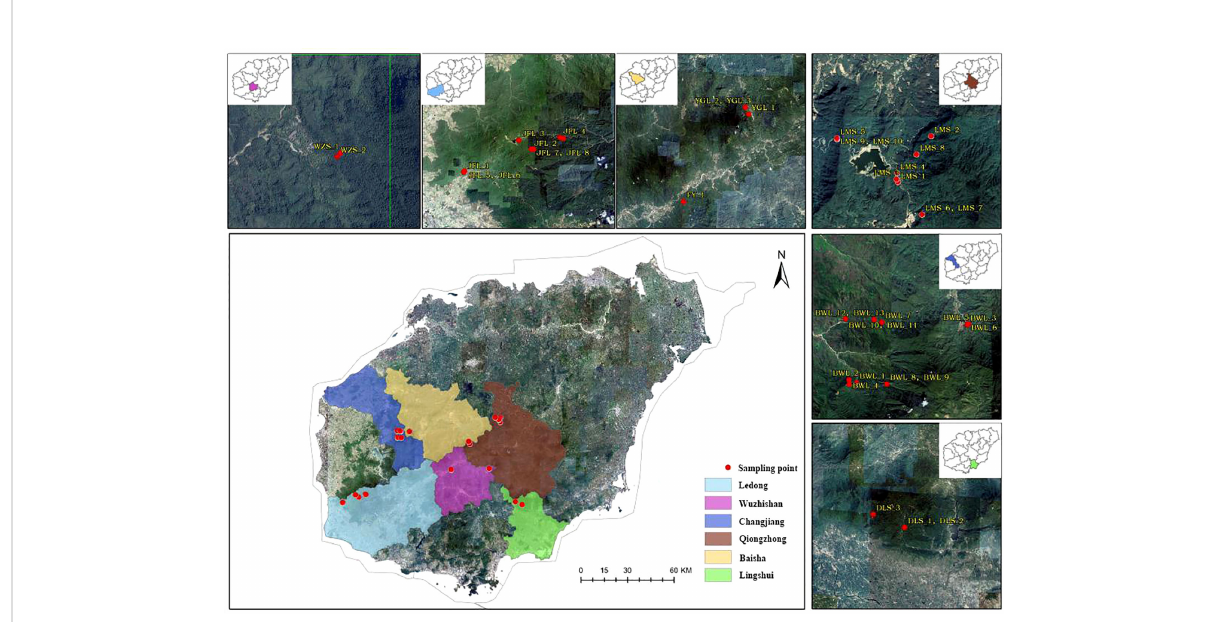
FIGURE 1 A distribution and sample collection information map of Hopea hainanensis in Hainan